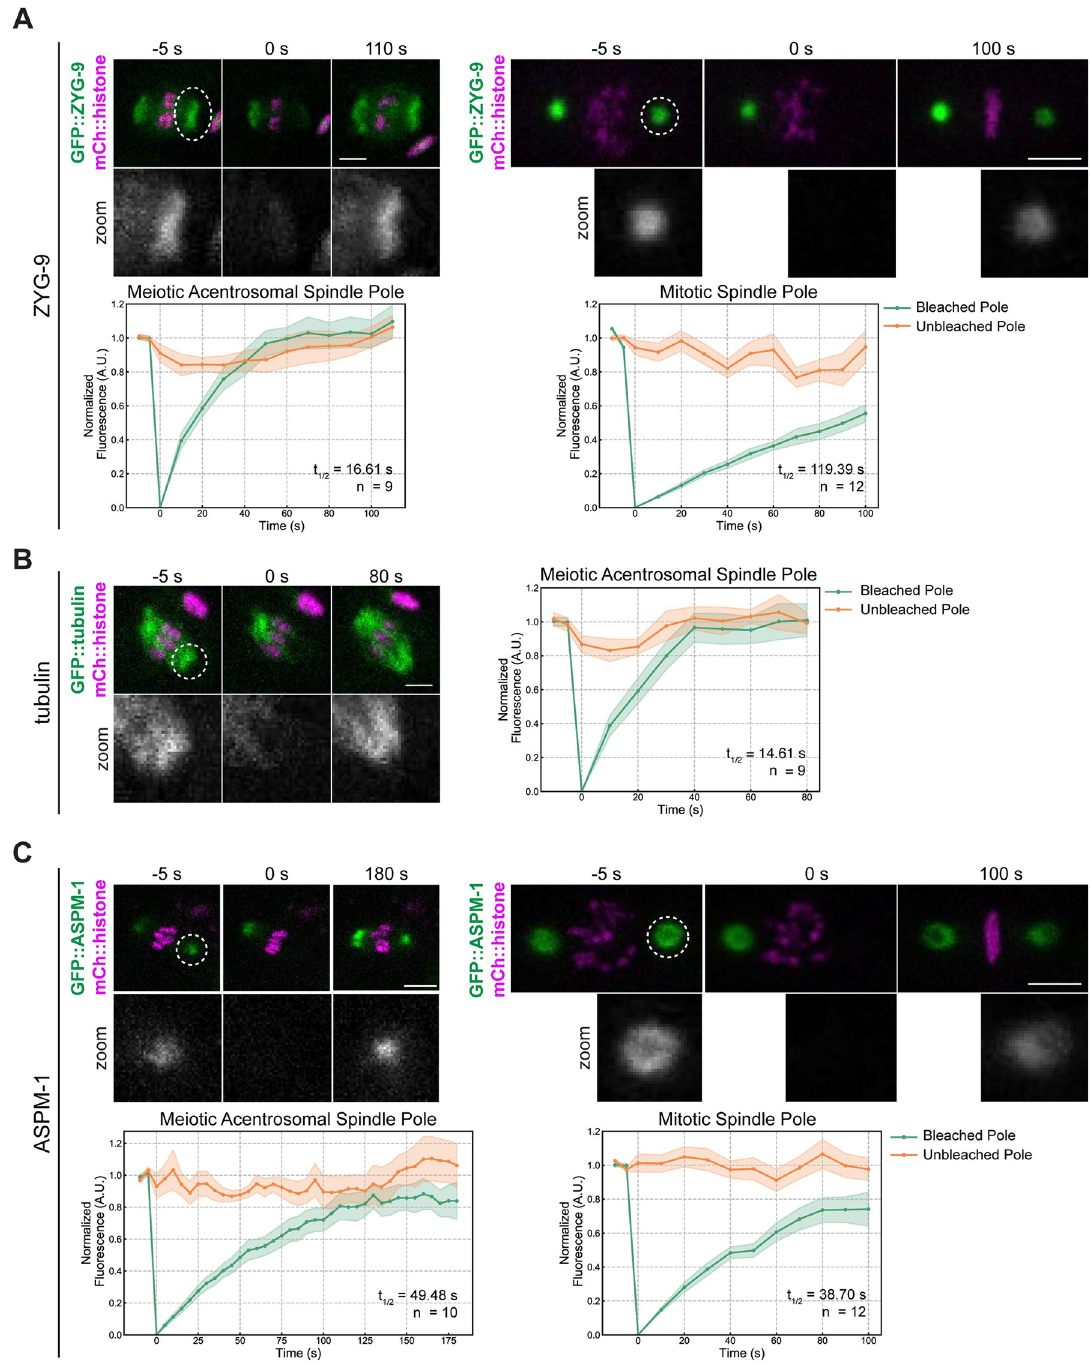
Fig 7. FRAP analysis of ZYG-9 and ASPM-1 at acentrosomal poles compared to at centrosomes. (A-C) FRAP recovery curves and stills from movies for ZYG-9 (A), tubulin (B), and ASPM-1 (C) at meiotic and mitotic spindle poles (except for tubulin; only recovery at the meiotic spindle is shown). In graphs, the bleached pole curve is green, the unbleached pole curve is orange, the solid lines are the average, and the standard error of the mean is shaded. For all images, the specified bleached protein is in green and the chromosomes are in magenta. Zooms show only the bleached region. t 1/2 was calculated from fitting the recovery curves to a single exponential function (Materials and Methods); see S5 Fig. n represents the number of spindles analyzed to generate each curve; movies for each condition were obtained across several days so represent multiple biological replicates. ZYG-9 is highly dynamic at acentrosomal spindle poles, displaying a similar recovery time to tubulin, while ASPM-1 turns over less rapidly and has similar dynamics at centrosome- containing and acentrosomal poles. Bars = 2.5 μ m (meiosis) and 5 μ m (mitosis).